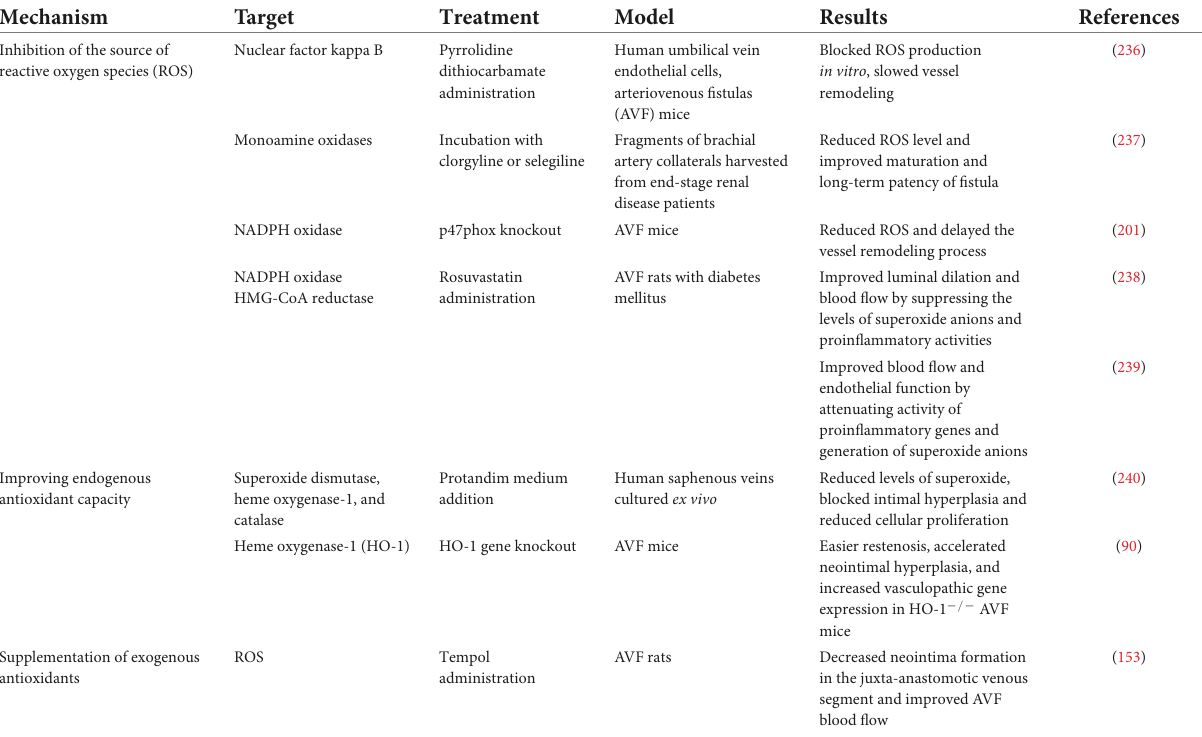
TABLE 1 Antioxidant therapies in AVF